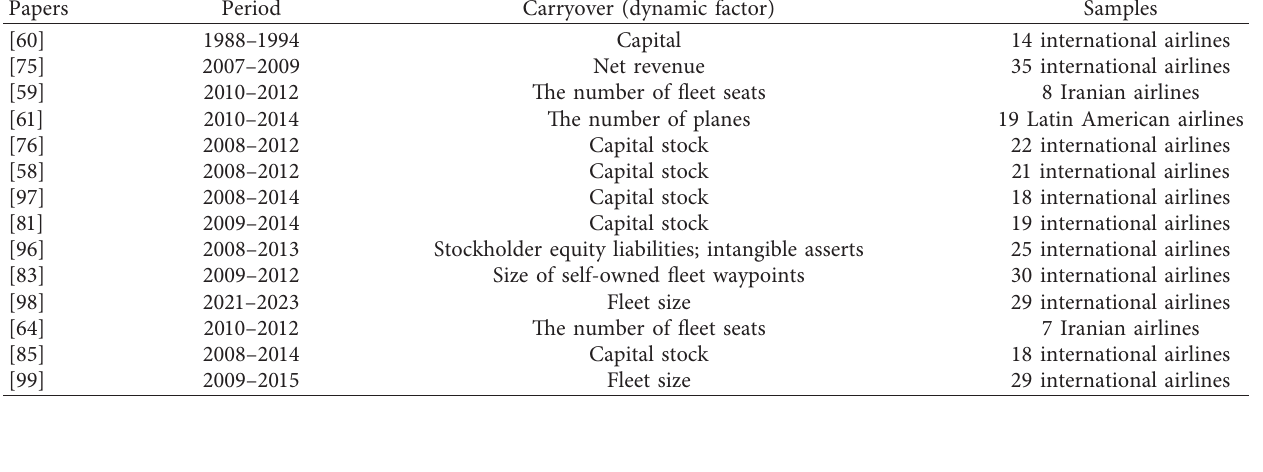
Table 6: Details of literature with dynamic DEA.